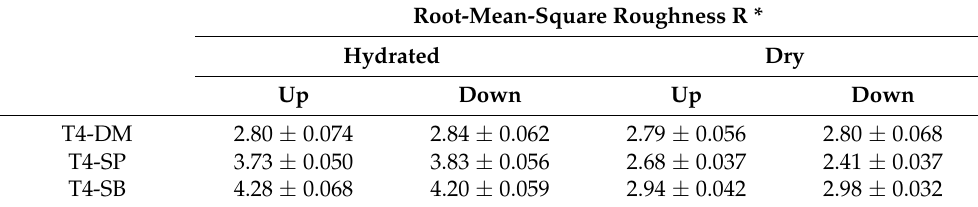
Figure 5. Solvent accessible surface area including hydrophobic and hydrophilic part of three antifouling membranes. Numbers above the bar means the proportion of hydrophilic area. Table 1. Root-mean-square roughness of three antifouling